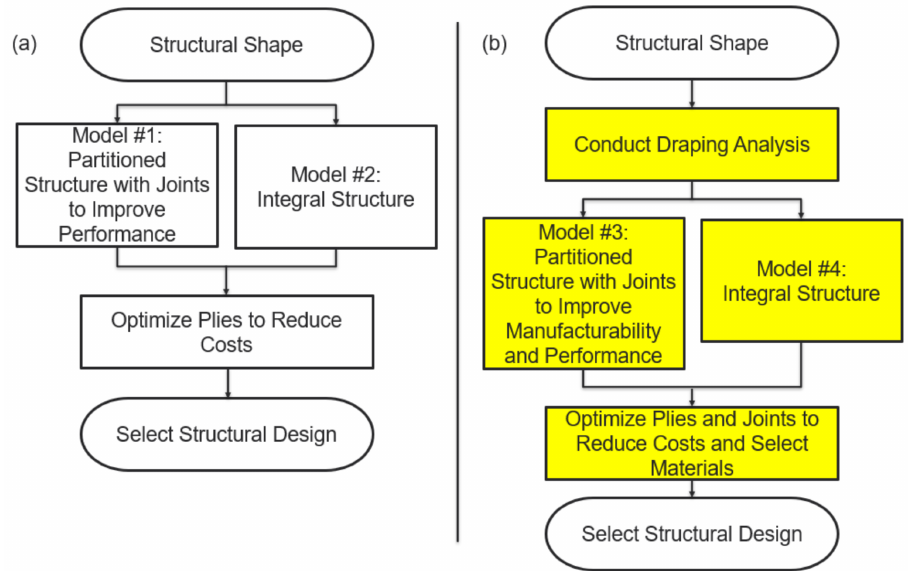
Figure 2. Segmentation and optimization approach applied in previous work ( a ) [18] compared to proposed methodology for this study ( b